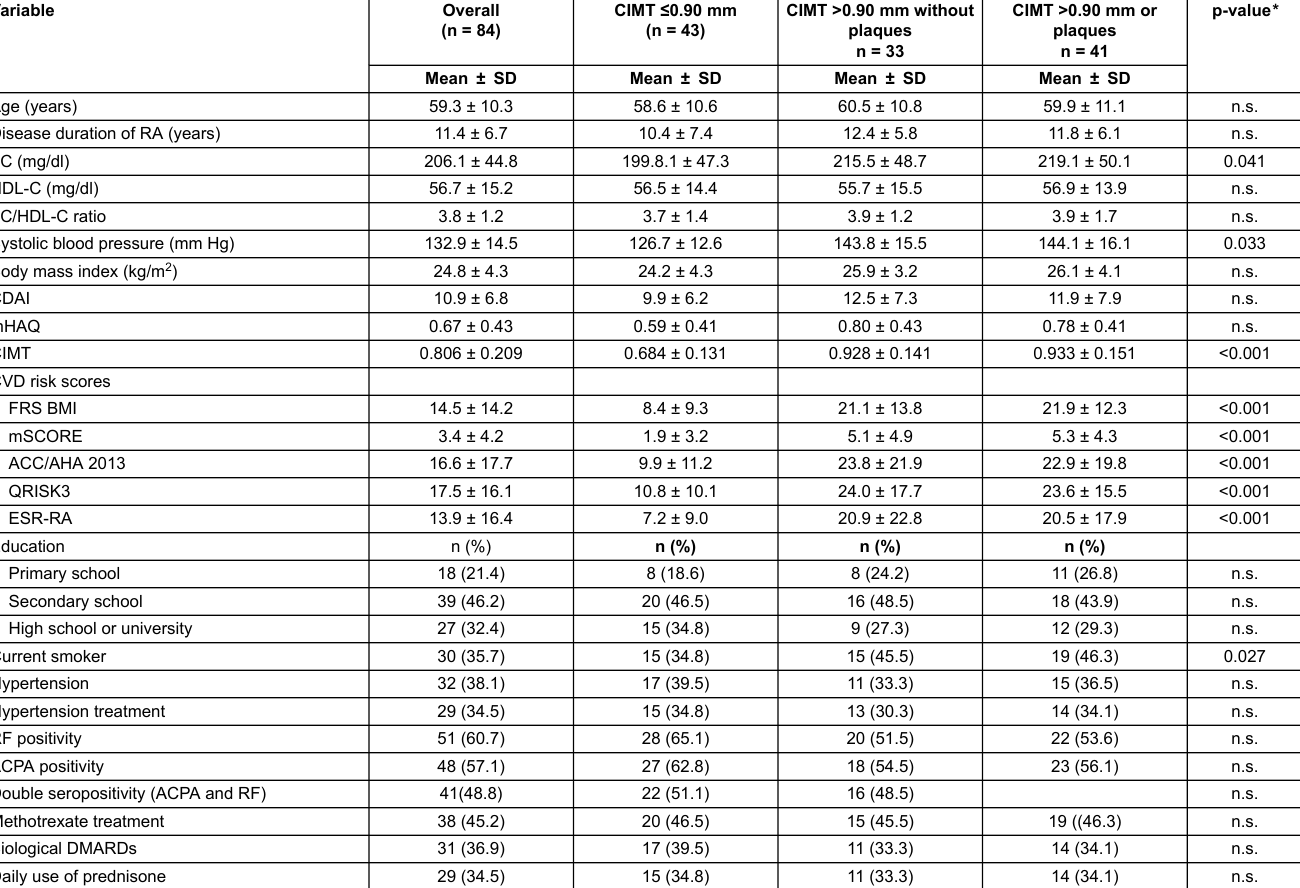
Table 2: Demographic characteristics of the whole cohort (84 subjects) and of the subgroups of patients according to carotid intima-media thickness (CIMT) stratification and plaque presence (CIMT ≤0.90 mm, n = 43 subjects; >0.90 mm, n = 33 subjects and n = 41 subjects >0.90 mm + carotid plaques).